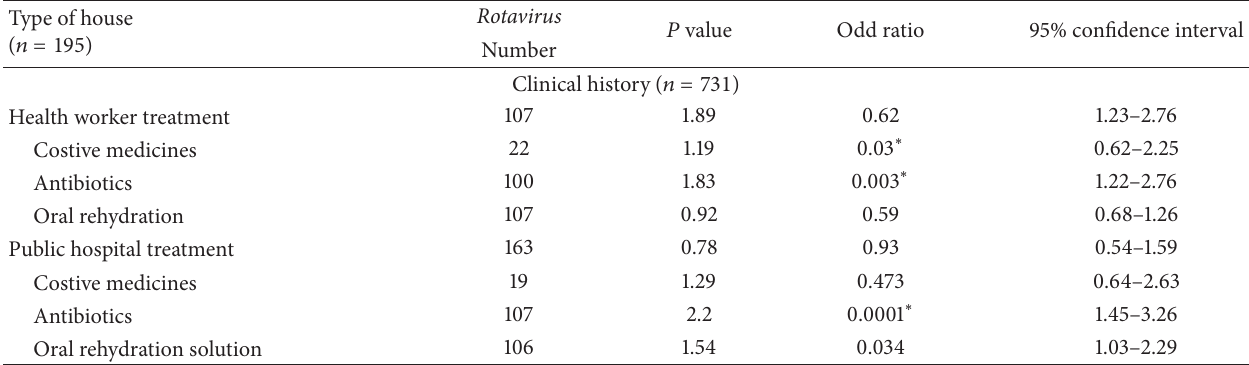
Table 4: Clinical history and Rotavirus diarrhea among children in Taiz,